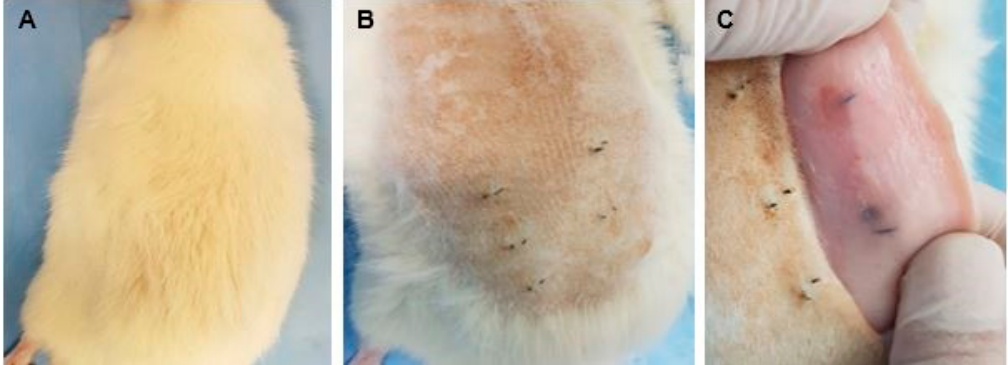
Figure 10. The dorsal area where the implantation was performed after 30 days. ( A ) Hair recovery; ( B ) absence of injuries and infections; ( C ) internal surface of the skin where the implanted samples encapsulated by scar tissue